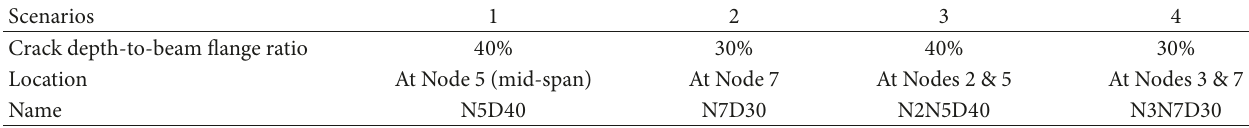
Table 1: Four damage scenarios considered in the numerical model